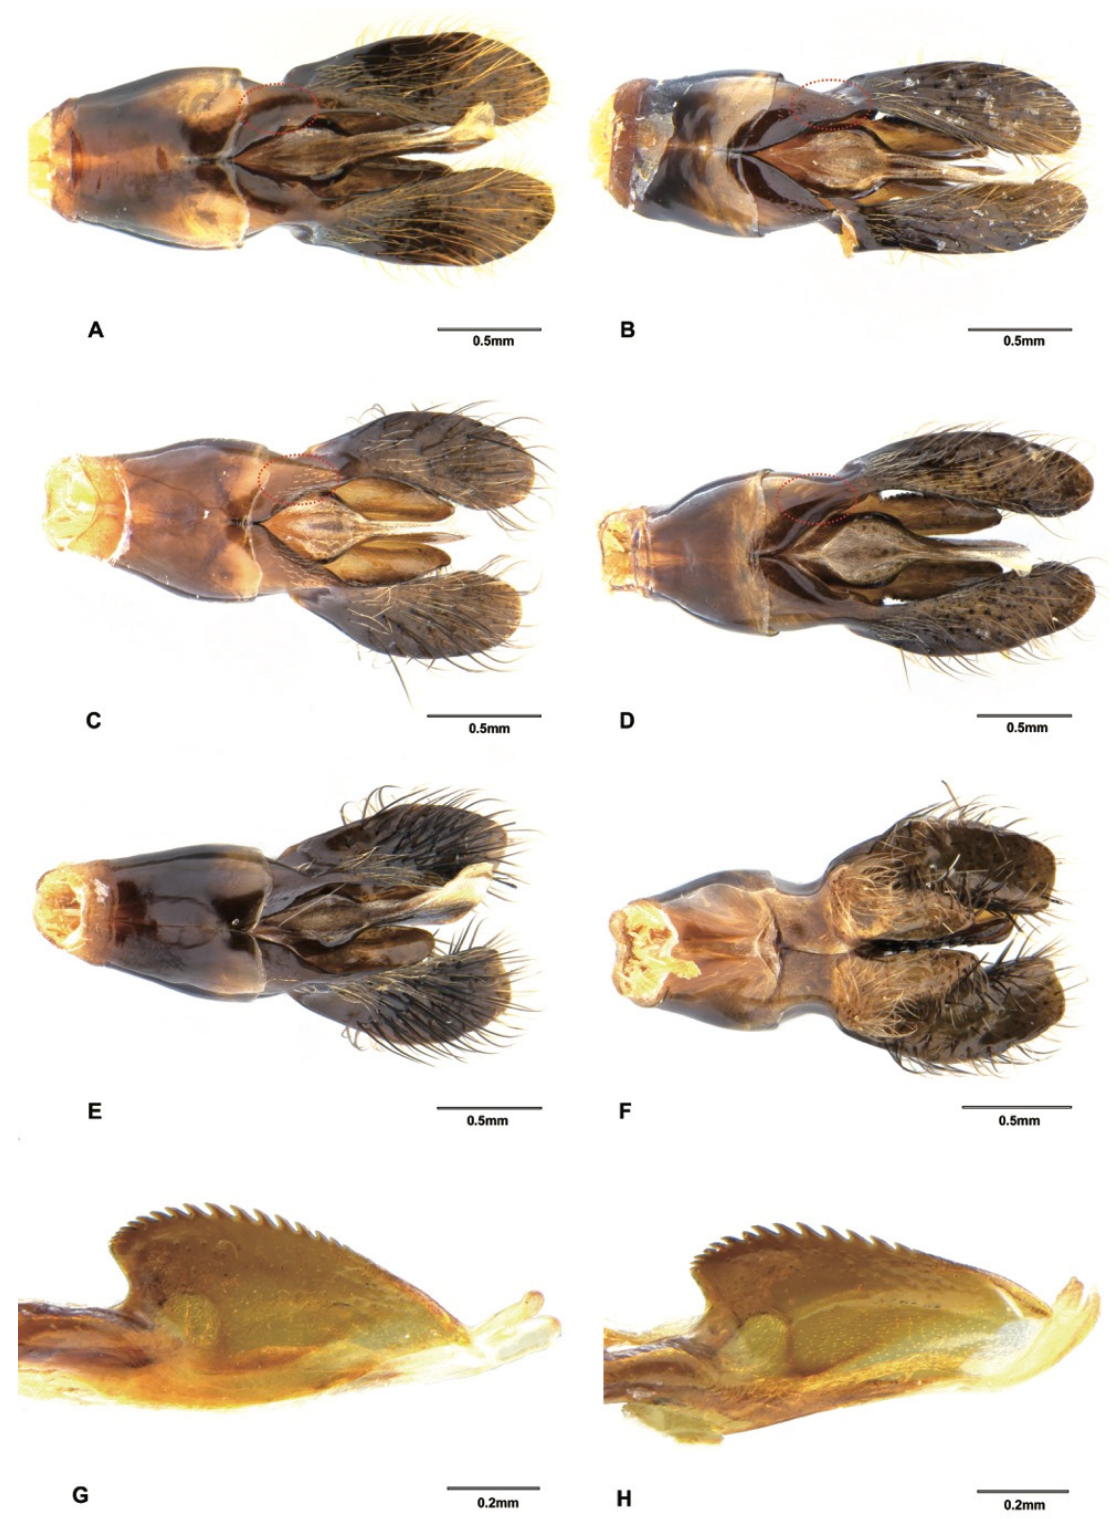
Figure 7. Male genitalia. ( A ) Scolia watanabei Smith, 1855 (En-418585), dorsal view; ( B ) Scolia watanabei Smith, 1855 (SCAU3043679), dorsal view; ( C ) Scolia superciliaris sauteri Betrem, 1928, dorsal view (SCAU3043677); ( D ) Scolia supercil- iaris superciliaris Saussure, 1864, dorsal view (SCAU3048010); ( E ) Scolia sp., (SCAU3043674) dorsal view; ( F ) Scolia sp., (SCAU3043674) ventral view; ( G ) Megacampsomeris shillongensis Betrem, 1928 (SCAU3043655), penis valve, lateral view; ( H ) Megacampsomeris prismatica (Smith, 1855) (SCAU3048015), penis valve, lateral